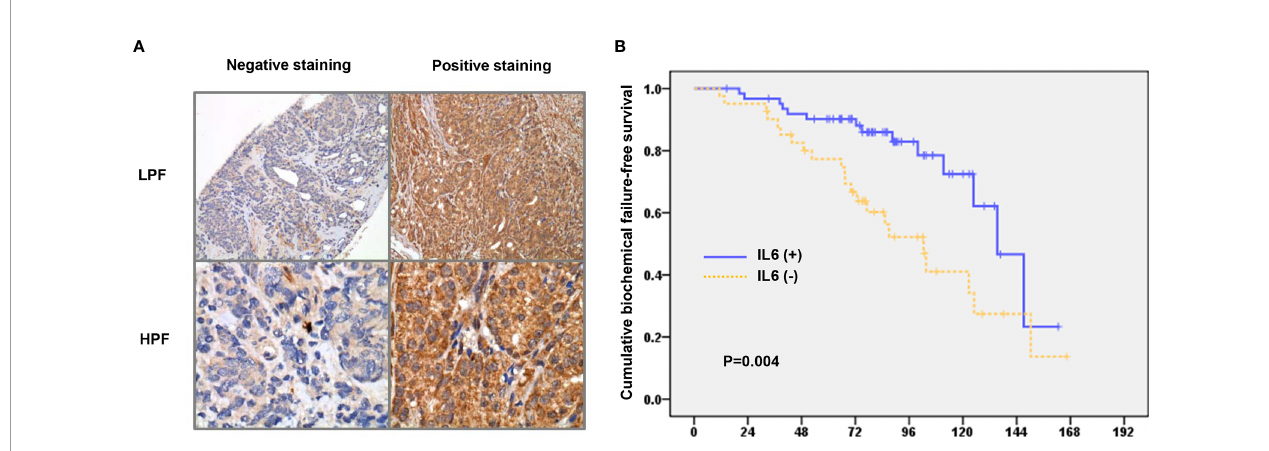
FIGURE 3 | Role of IL-6 in prostate cancer patients treated with de fi nite radiotherapy. (A) Representative slides of tumor specimens positively or negative staining for IL-6 are shown (LPF, lower power fi eld; HPF, high power fi eld). (B) The differences of biochemical failure-free survival according to the staining of IL-6.